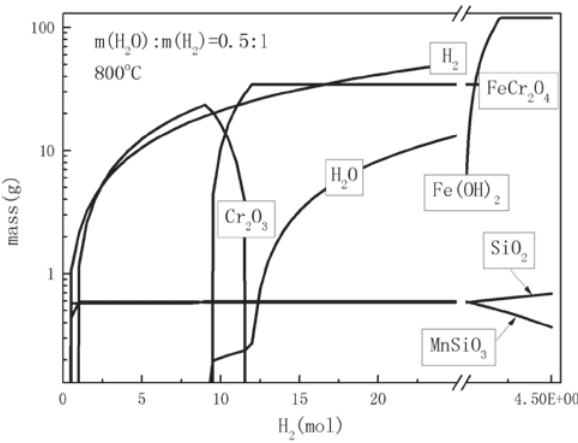
Fig. 6: Equilibrium of H 2 O/H 2 (mass ratio: 0.5/1) to Fe-Cr alloys at different